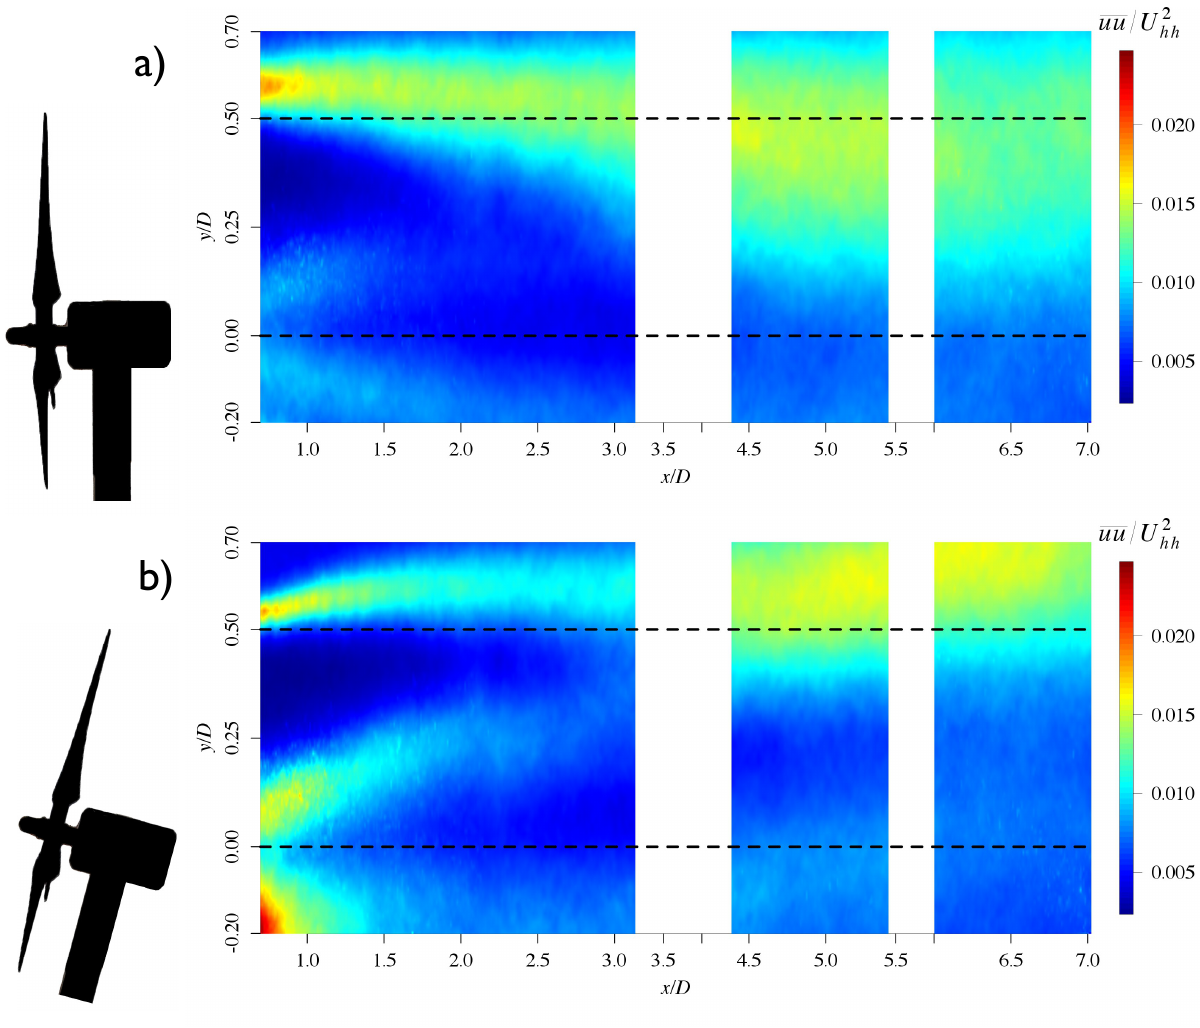
Figure 12. Contour of the normalized uu / U 2 cases. In the fixed case, most of the stress is created above blade tip and extends downward with increasing x/D . In the floating case, high uu / U 2 tip top. Hub height ( y/D = 0) and top blade tip ( y/D = 0.5) are indicated by dashed horizontal